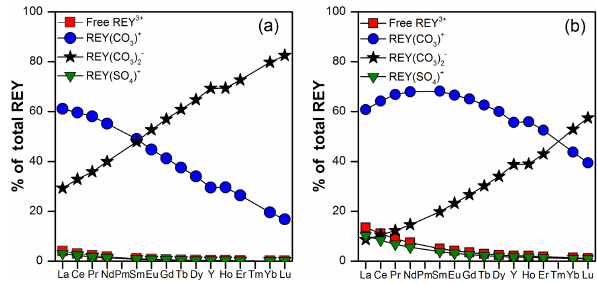
Figure 5. REY speciation in the North Sea water at 25 ◦ C for (a) pH 8.2 and (b) pH 7.6 (as modeled using